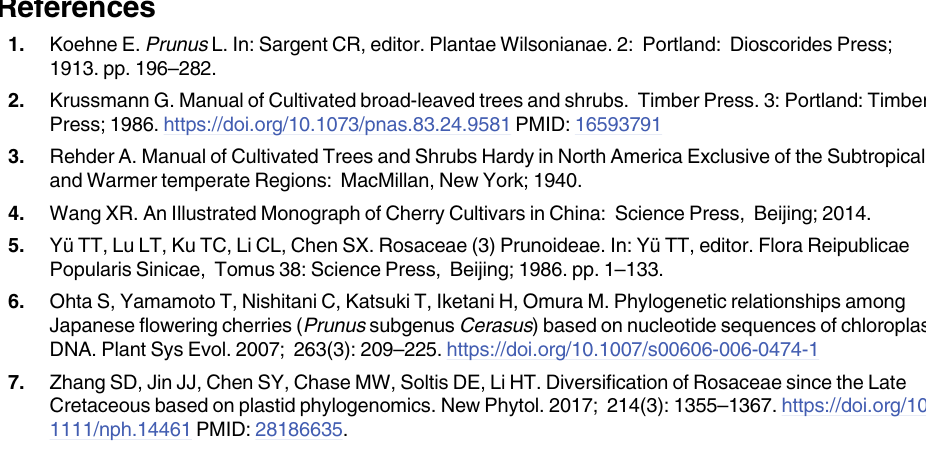
S5 Table. Summary for all the information of 33